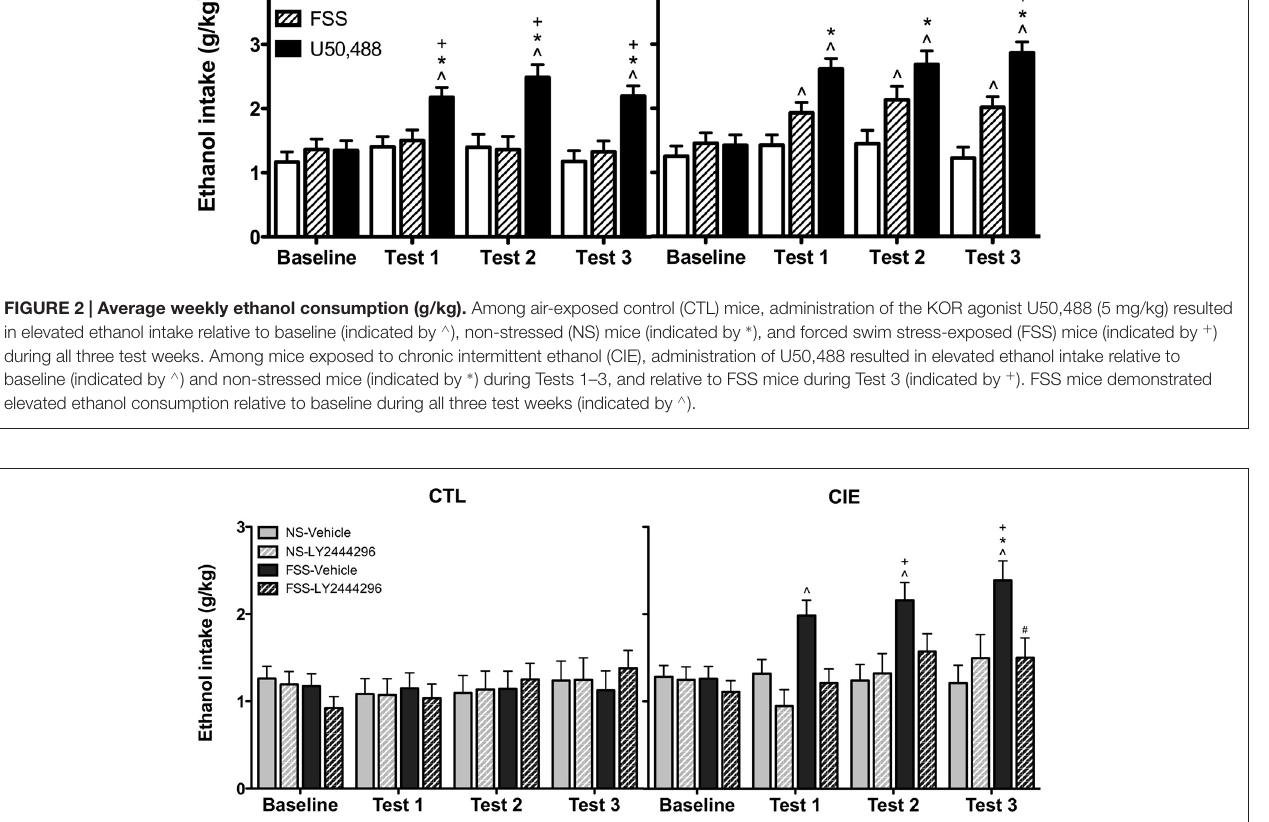
FIGURE 3 | Average weekly ethanol consumption (g/kg). Among air-exposed control (CTL) mice, no effects of stress, chronic ethanol exposure (CIE), or KOR blockade were observed. Among CIE-exposed mice, FSS exposure (solid black bars) increased ethanol consumption relative to baseline consumption during all three test weeks (indicated by ∧ ), relative to CTL-FSS mice during Tests 2–3 (indicated by + ), and relative to CIE-NS mice during Test 3 (indicated by ∗ ). Pretreatment with the KOR antagonist LY2444296 (striped black bars) blocked the FSS-induced increased drinking in CIE mice and resulted in a significant reduction from CIE-FSS vehicle mice during Test 3 (indicated by #